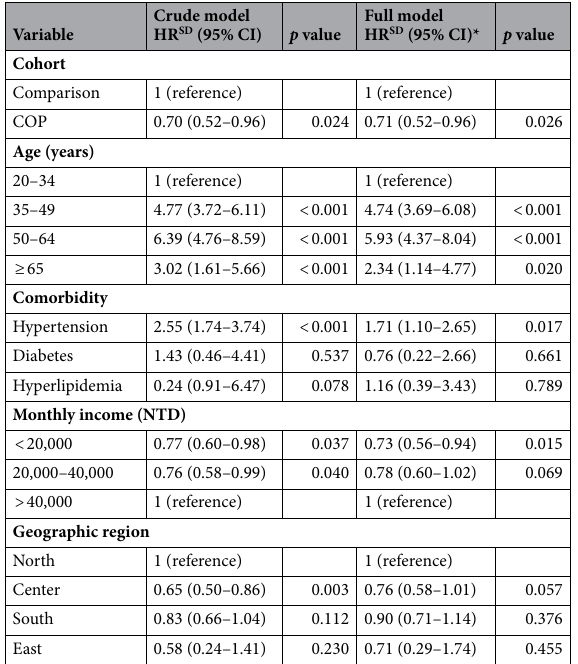
Table 4. Independent predictors for breast cancer in all patients of the two cohorts after 1 year of follow-up. The independent predictors were identified through competing risk regression analysis. COP carbon monoxide poisoning, HR hazard ratio, AHR adjusted hazard ratio, HR SD adjusted competing risks hazard ratio, CI confidence interval, NTD New Taiwan Dollars. *Adjusted for age, hypertension, diabetes, hyperlipidemia, monthly income, and geographic